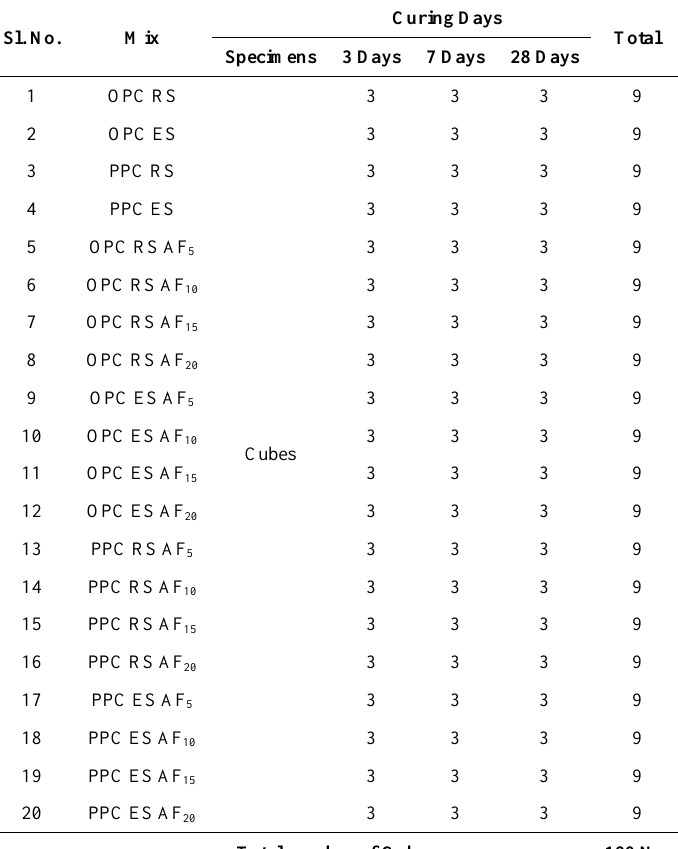
Table 7. Details of number of specimens for cement mortar